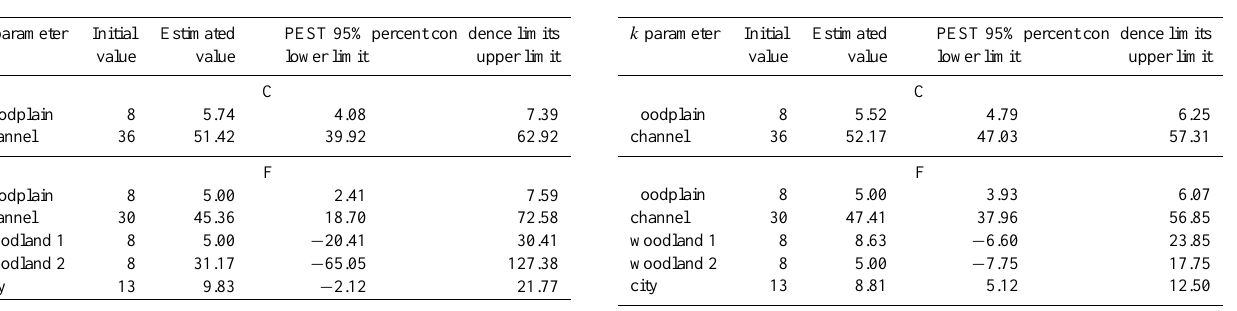
Table 7. Calibration results as given by PEST considering 143 data